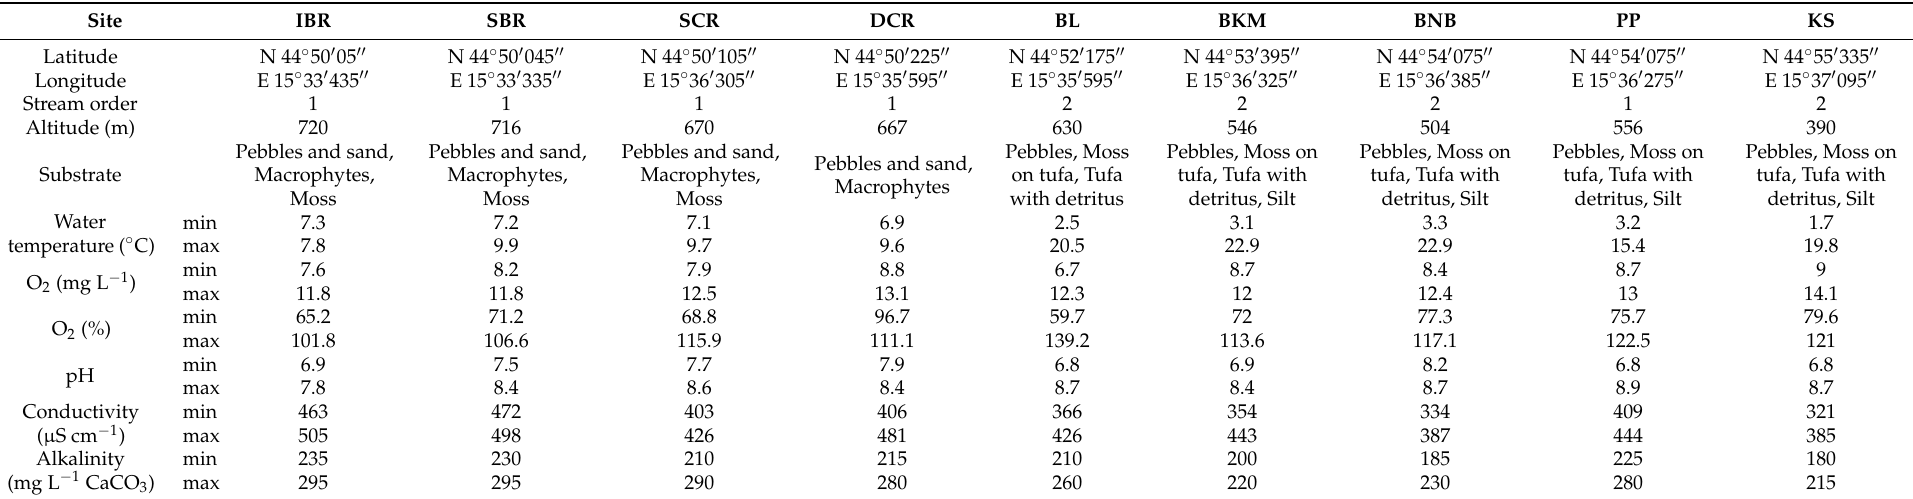
Table 1. Characteristics of the sampling sites in the Plitvice Lakes NP. IBR—Spring of Bijela rijeka, SBR—Upper reach of Bijela rijeka, ICR—Spring of Crna rijeka, SCR—Upper reach of Crna rijeka, DCR—Middle reach of Crna rjeka, BL—Tufa barrier Labudovac, BKM—Tufa barrier Kozjak-Milanovac, BNB—Tufa barrier Novakovi´ca Brod, PP—Stream Plitvica, KS—River